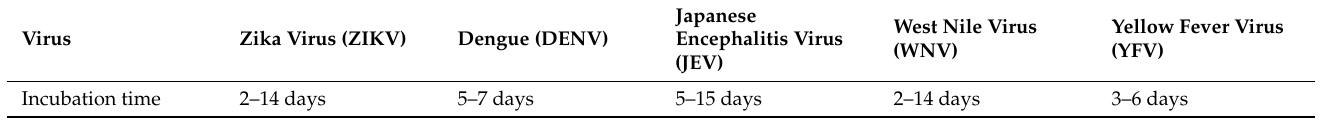
Table 1. Features of flavivirus infections in